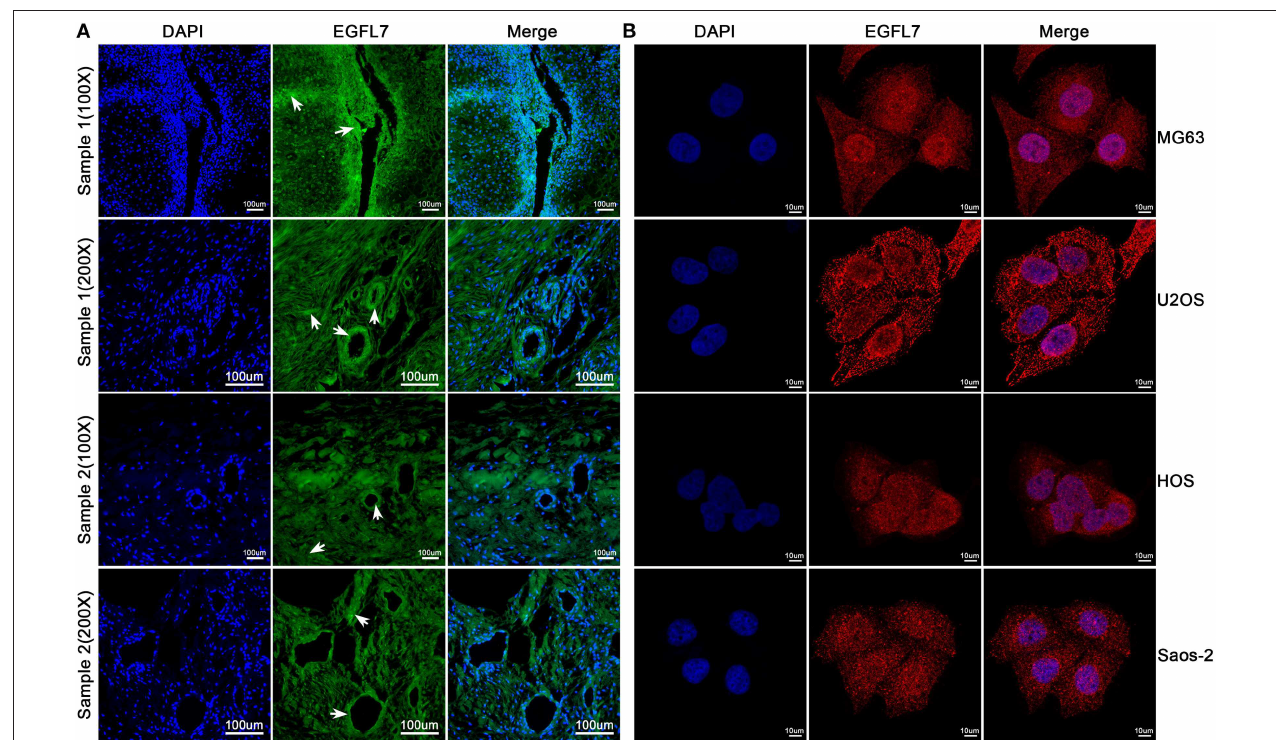
FIGURE 3 | Immunofluorescence technique was used to verify the expression of EGFL7 from histological and cytological aspects, respectively. (A) As seen in these representative images, the EGFL7 was labeled by special anti-EGFL7 antibody, and the cell nuclei were stained by DAPI. The merged image shows that green fluorescent signals for EGFL7 protein were expressed in both tumor tissues and vascular endothelial cells, and we have observed this expression from multiple samples and different optical multiples, respectively. White arrows indicate positive areas. (B) From the immunofluorescence results of OS cells, the EGFL7 protein was labeled by red fluorescent, the cell nuclei were stained by DAPI. The expression of EGFL7 protein in OS cells is located in the cytoplasm.